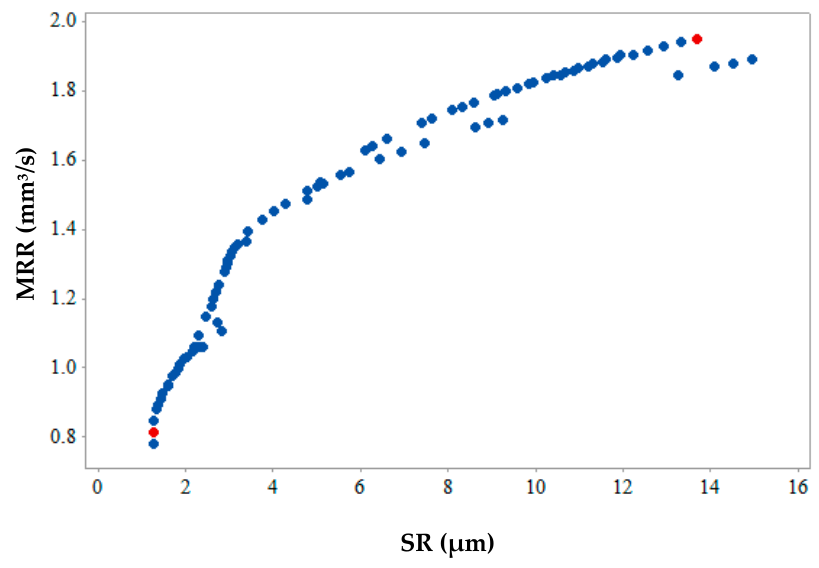
Figure 12. 2-D Pareto optimal points for MRR vs SR.